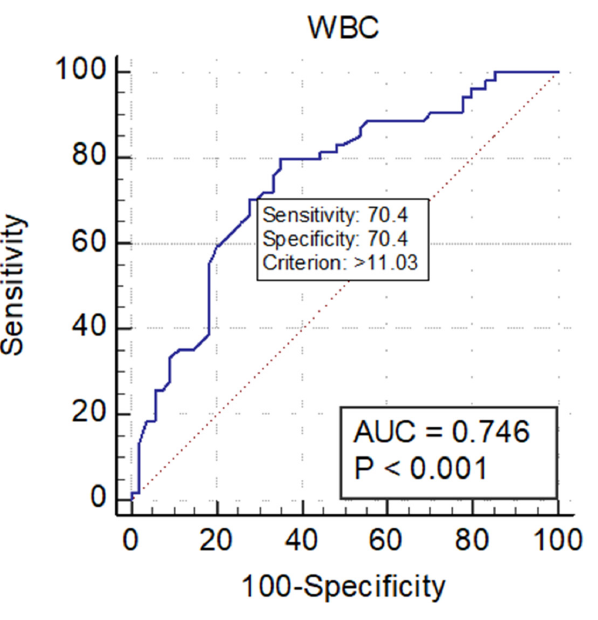
Figure 2. Corresponding point of cut ‐ off values of WBC on the ROC curve (AUC) (Se = Sp).